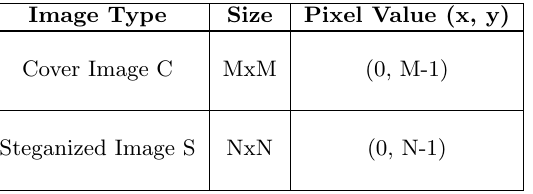
Table 1: Summary of size and pixel range for the cover image and the steganographic